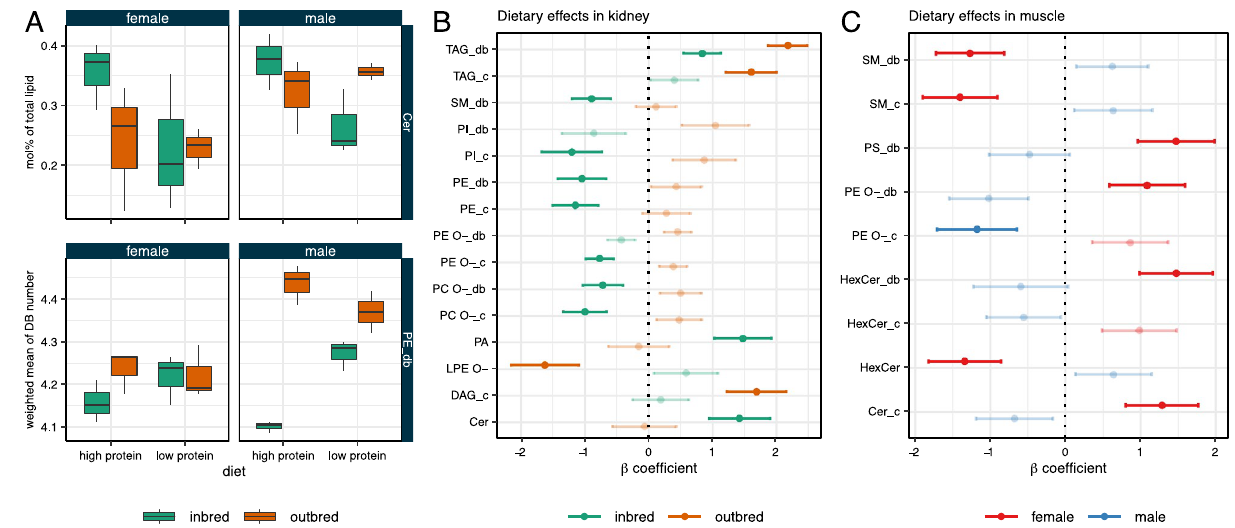
Figure 5. ( A ) Genotype-specific effects of diet on ceramide levels and degree of PE unsaturation in kidney. ( B ) Genotype- and sex-specific ( C ) and effects of diet based on a multiple linear regression including interaction between diet and genotype and diet and sex, respectively. Shown are β coefficients. Error bars indicate standard error. Significantly affected features ( p < 0.05 for the interaction term) are displayed non-transparently. Lipidomic features are depicted on the y axis (with “_db” denoting the weighted mean double bond number and “_c” denoting the weighted mean of the carbon chain length of a lipid class; when neither is specified, the feature name refers to lipid class